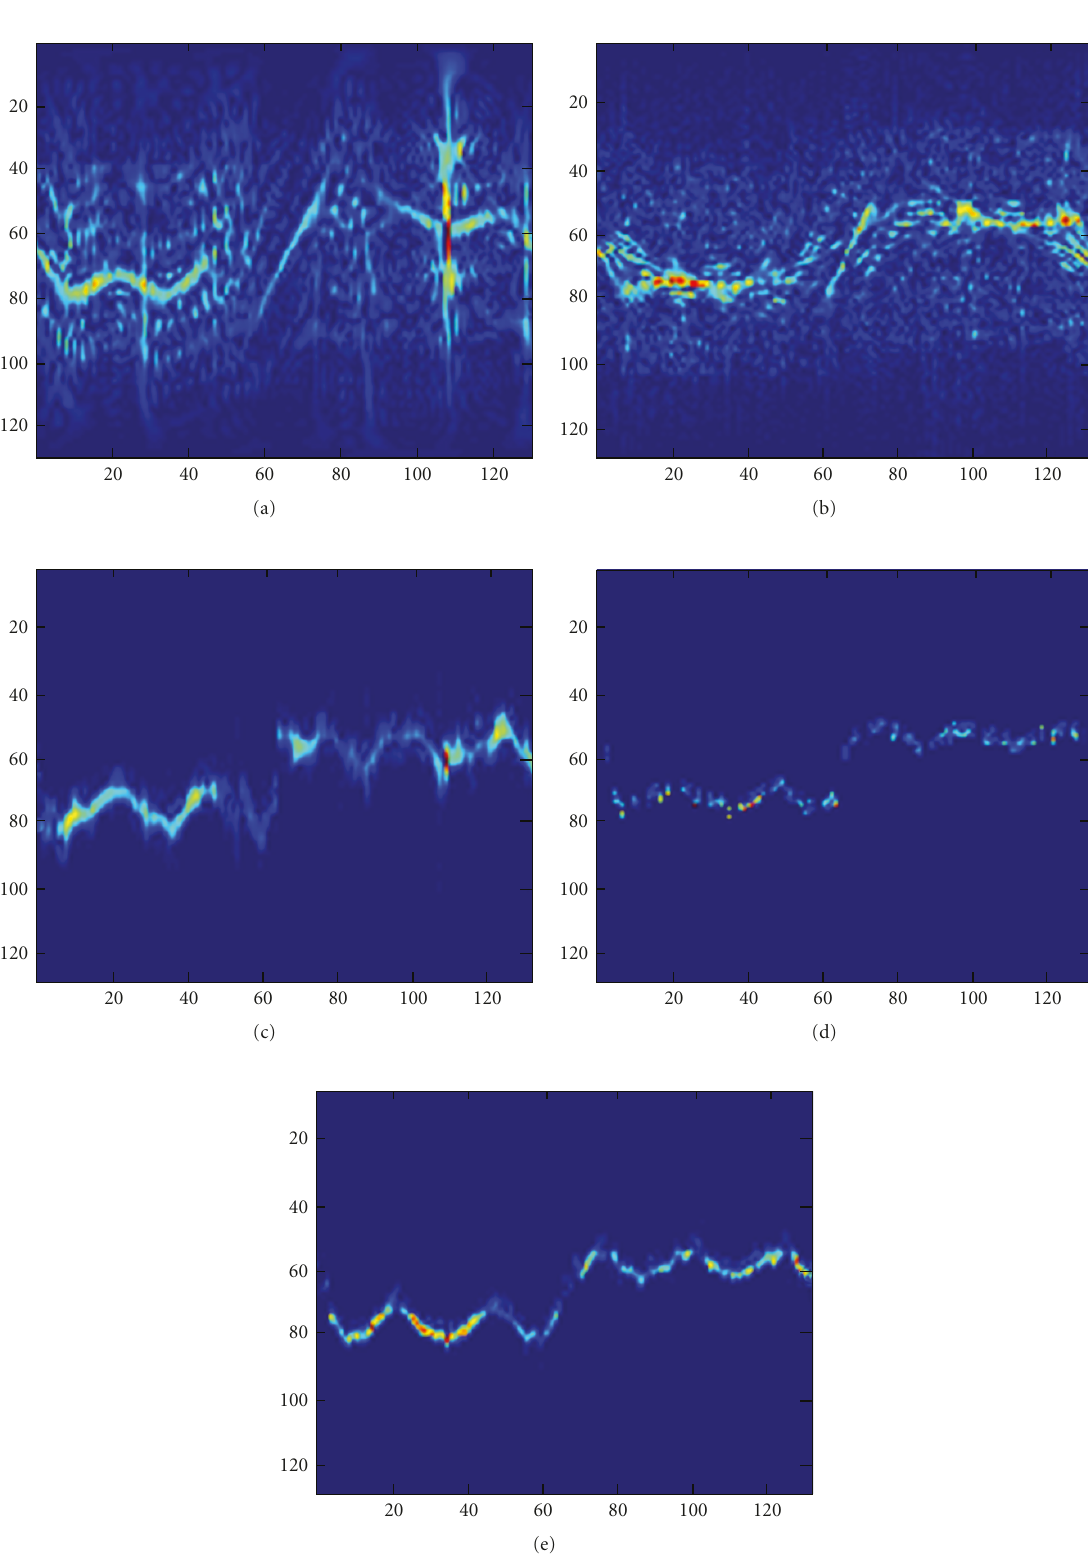
Figure 1: Time-frequency representations for signal x 1 ( n ) by using (a) the standard WD, (b) the L-estimate WD, (c) the standard CTD N = 4 , (d) the marginal median RCTD N = 4 , and (e) the L-estimate RCTD N = 4